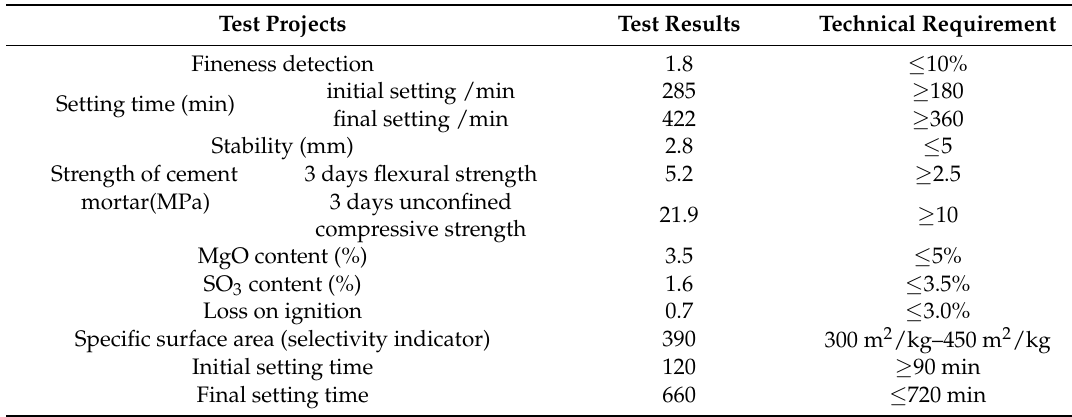
Table 1. Technical indicators of cement.